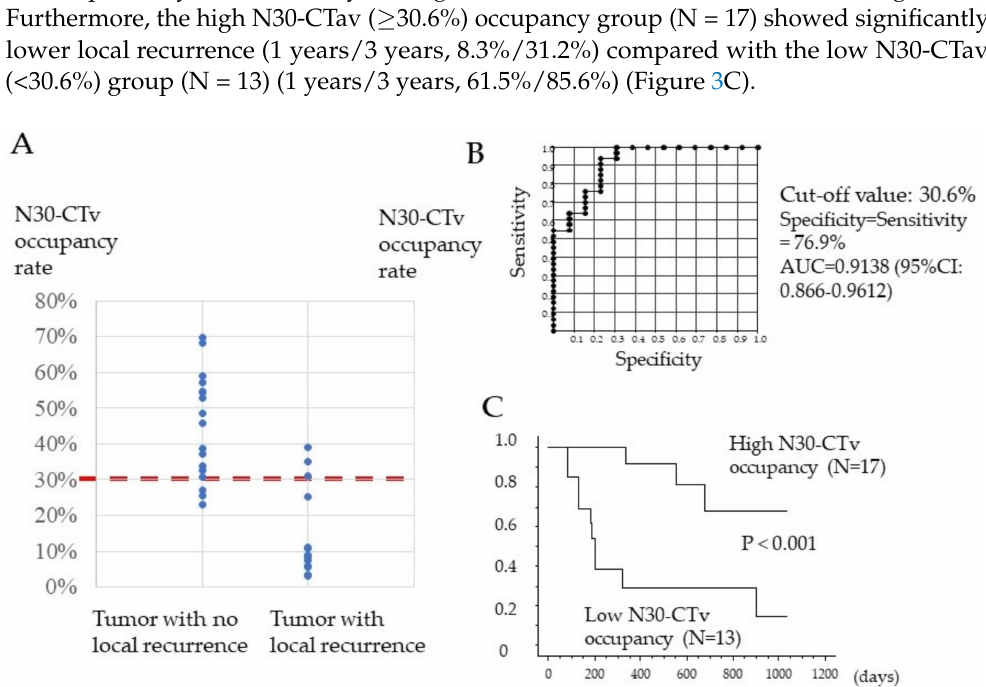
Figure 3. Association between percentage of tumor tissue with CT attenuation values (30 HU) that could be predictive of necrosis (N30-CTav) occupancy and local recurrence-free survival. ( A ) Dis- tribution of N30-CTav occupancy rates between hepatocellular carcinoma (HCC) tumors with local recurrence and HCC tumors with no local recurrence. N30-CTav, threshold CT value (30 HU) for his- tological necrosis in tumors diagnosed as complete response after lenvatinib treatment. ( B ) Receiver- operating characteristic (ROC) curve analysis of the N30-CTav occupancy rate for predicting local recurrence and no local recurrence. AUC, area under the ROC curve. N30-CTav, a CTav of 30 HU was set as the threshold value for histological necrosis. ( C ) Kaplan-Meier analysis of local tumor progression in 30 tumor lesions with a complete response, stratified by the N30-CTav occupancy rate (grouped by N30-CTav occupancy cut-off values of ≥ 30.6% and